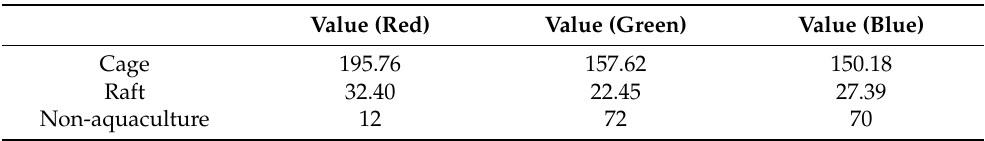
Figure 4. Thematic map showing the marine aquaculture zones in Sansha Bay. Table 2. Average grayscale values of different types of aquaculture zones in the region shown in Figure 4 under different wavelength bands.